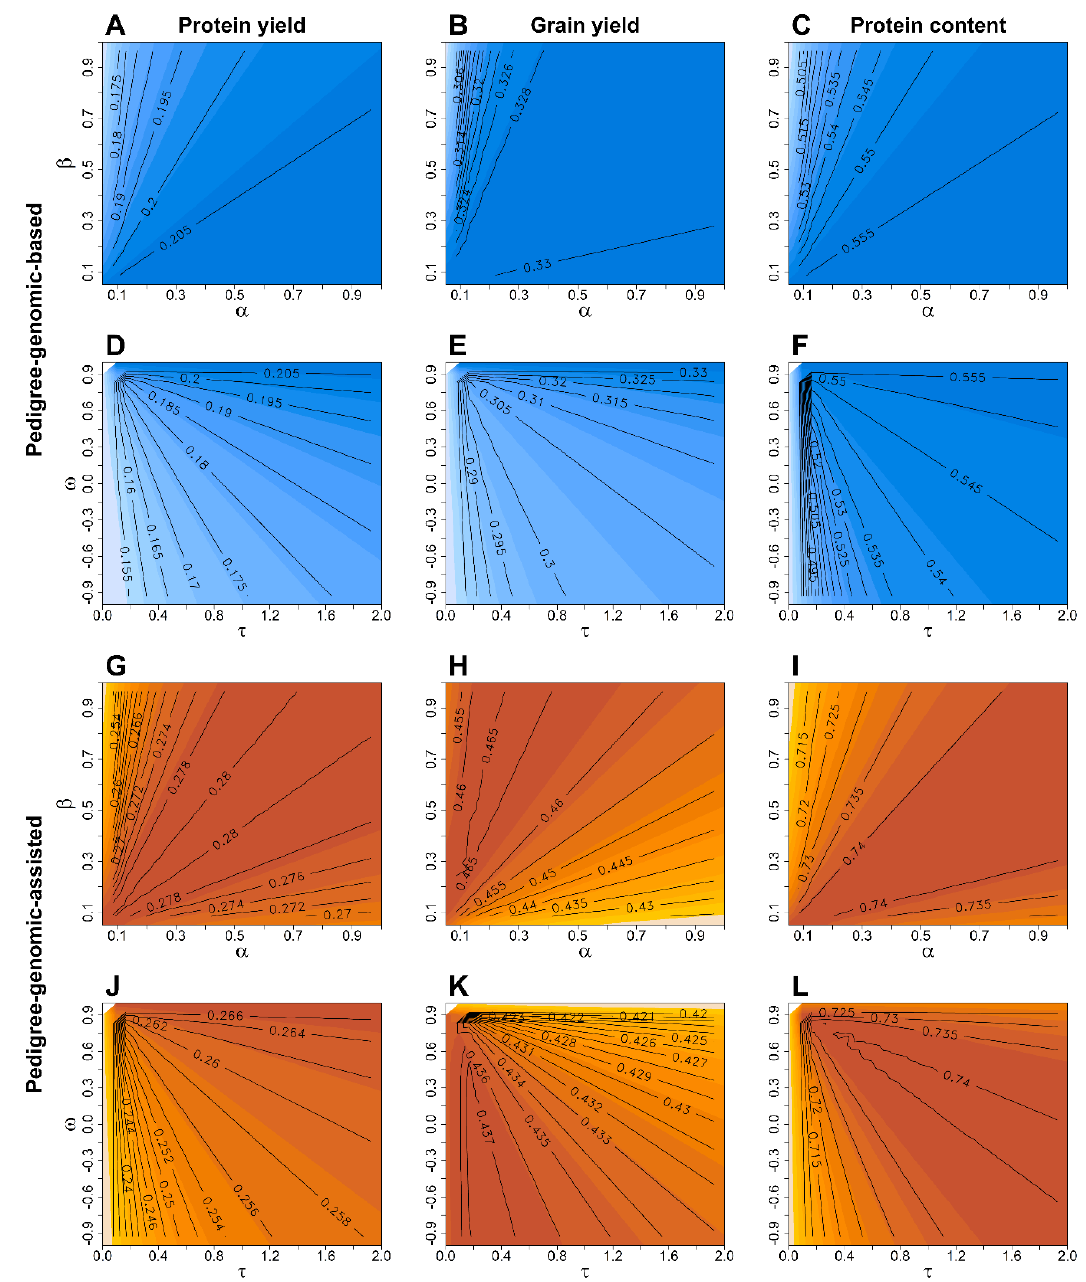
Figure 2. Average prediction accuracy for protein yield (first columns), grain yield (central column), and protein content (right column) obtained from the 50 times repeated resampling scheme with a 3-year training population and a scenario where all lines in the training and validation population are genotyped to derive pedigree-genomic-based ( A – F ; blue coloured) and pedigree-genomic-assisted predictions ( G – L ; red coloured) with the latter exploiting pre-existing information of the validation population from preliminary yield trials. The weight of the scaling factors α , β , τ , and ω to create the relationship matrix H − 1 (Equation (6)) were altered in a grid search, where the factors α and β were kept constant at α = 1 and β = 0 when varying τ and ω , whereas τ and ω were kept constant at ω = 1 and τ = 1 when modifying α and β . Isolines of same prediction accuracy for di ff erent combinations of the scaling factors are highlighted in black colour, while a darker colouring within the respective subplots A–L indicates a higher prediction accuracy for the particular model and scaling factor combination.